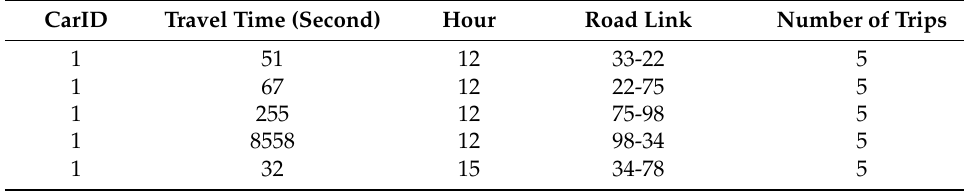
Table 1. Examples of tensor